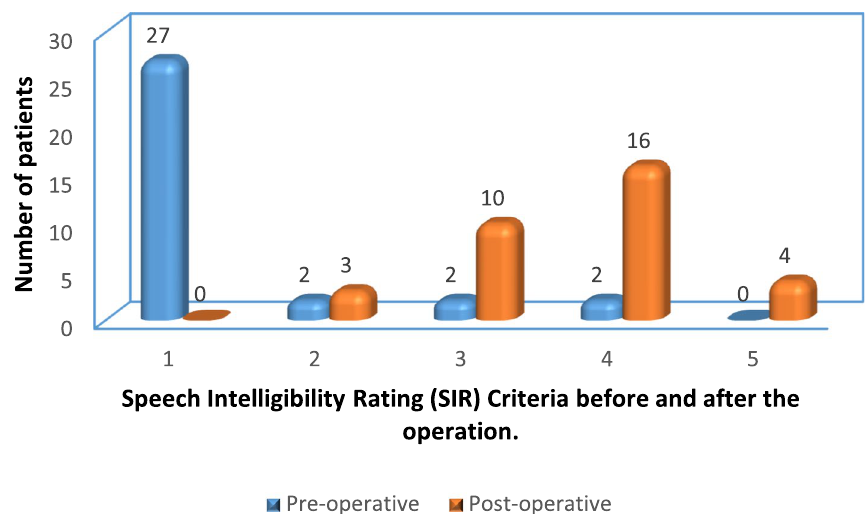
Fig. 4 Comparison of Speech Intelligibility Rating Criteria before and after